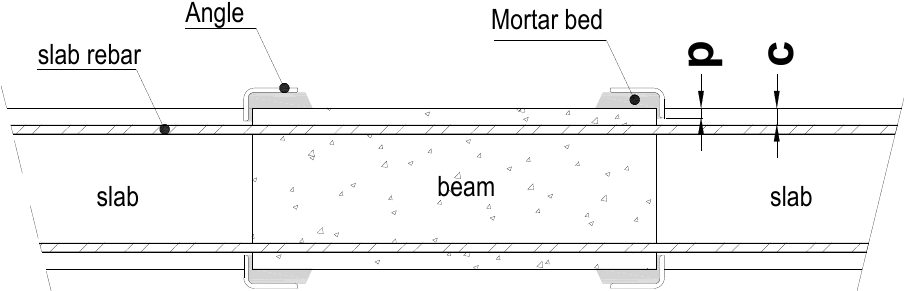
Figure 3. Cross section detail of application of steel angles in real cases (before installing stainless steel ribbons).